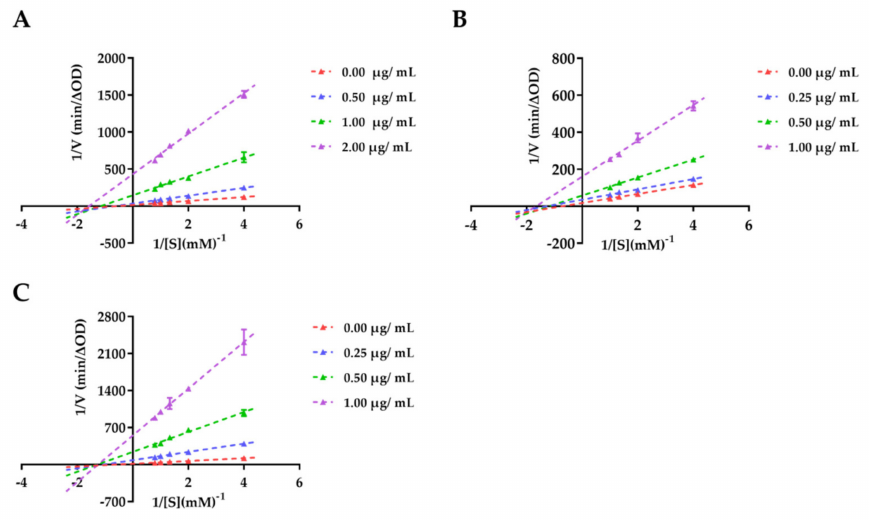
Figure 2. Lineweaver–Burk plots for the inhibition of α -glucosidase by NBF, NBF2, and NBF3 using p -NPG. ( A ) Lineweaver–Burk plots of NBF on α -glucosidase, ( B ) Lineweaver–Burk plots of NBF2 on α -glucosidase, and ( C ) Lineweaver–Burk plots of NBF3 on α